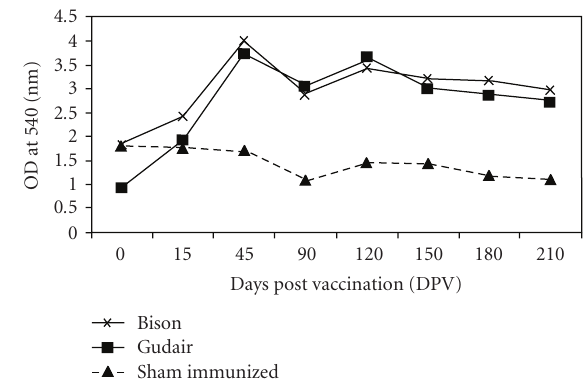
Figure 3: Comparison of Nitric Oxide concentration (Cellular Immune response) in vaccinated and sham-immunized groups at di ff erent time intervals.